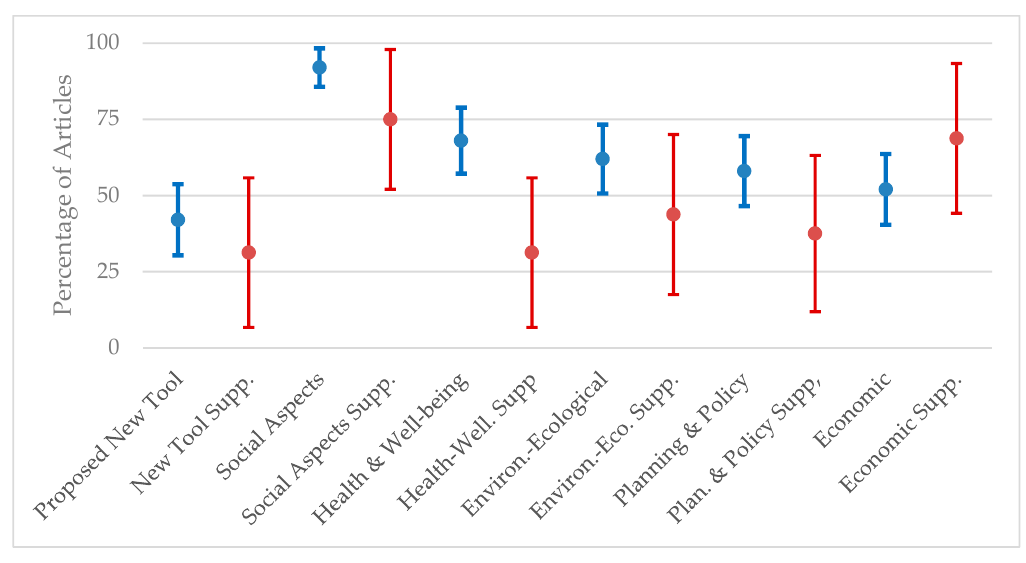
Figure 11. Comparison of changes in reporting rates ( ± 95% CIs of proportions) for research focuses identified in initial (Blue Data) and supplementary (Dark Red) searches. Supp. = Supplementary, Well. = Well-being, Environ. = Environmental, Eco. = Ecological, and Plan. = Planning.